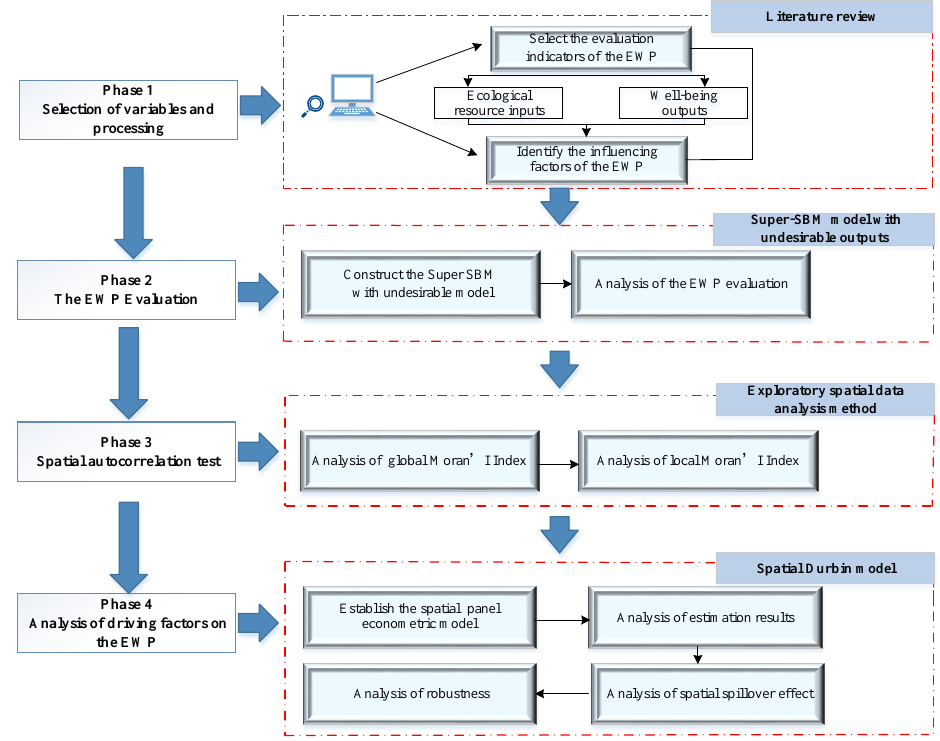
Figure 2. The flowchart of the research methods used in this study.